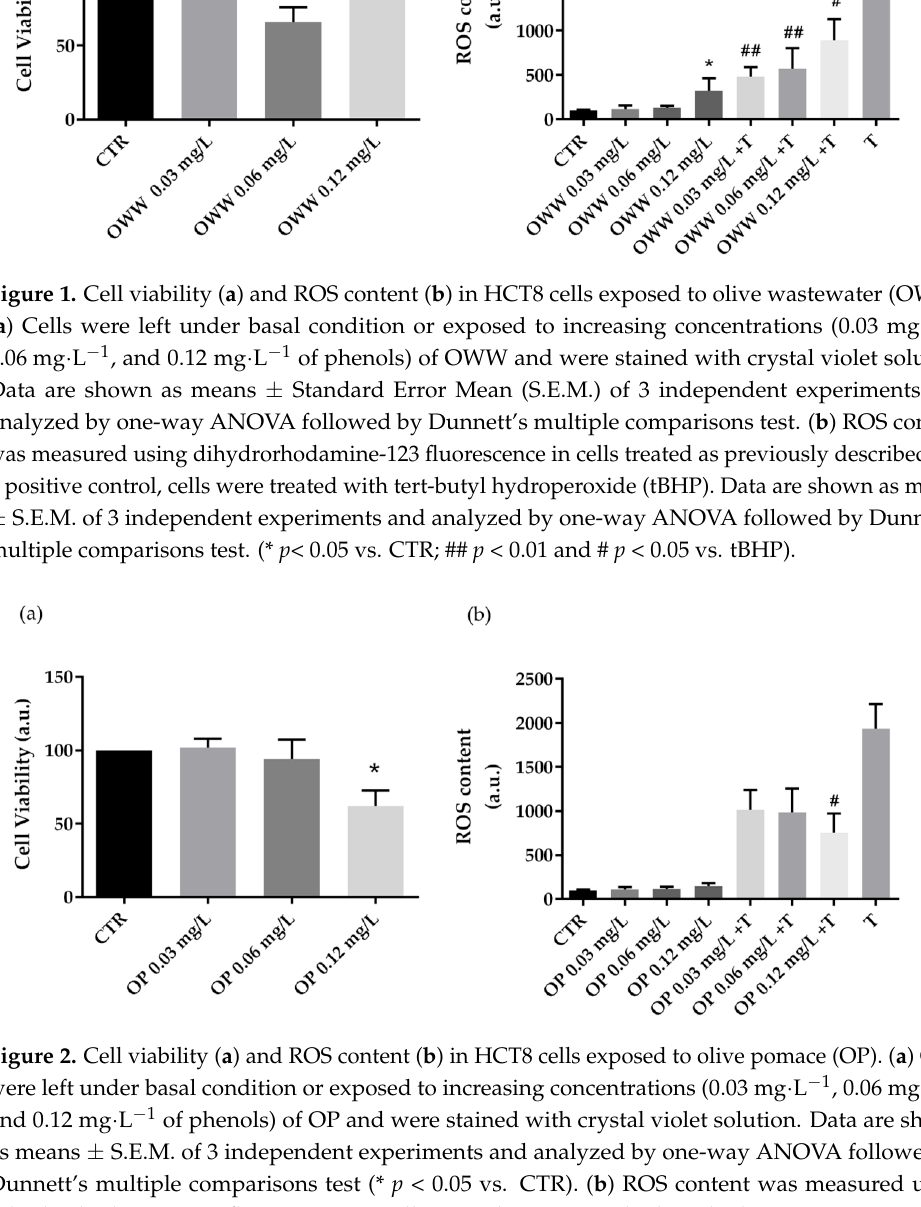
content. Incubation with the OLE alone, at increasing concentrations (0.03 mg L − 1 , 0.06 mg L − 1 , and 0.12 mg L − 1 of phenols) does not alter ROS content (Figure 3b).